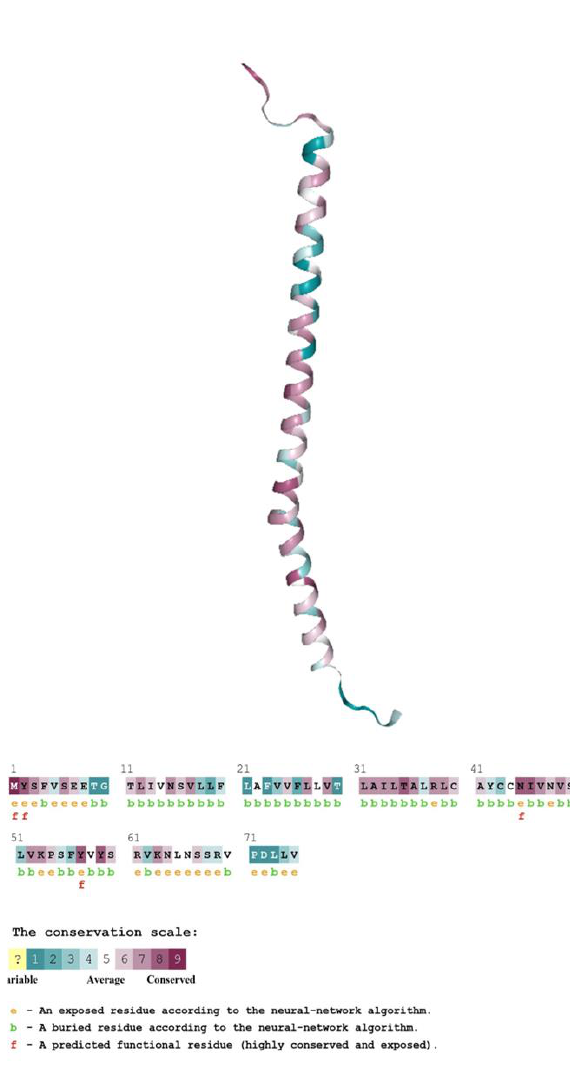
Figure 1. The residue conservation view of the SARS-CoV-2 E protein obtained by projecting conservation scores onto the protein structure and